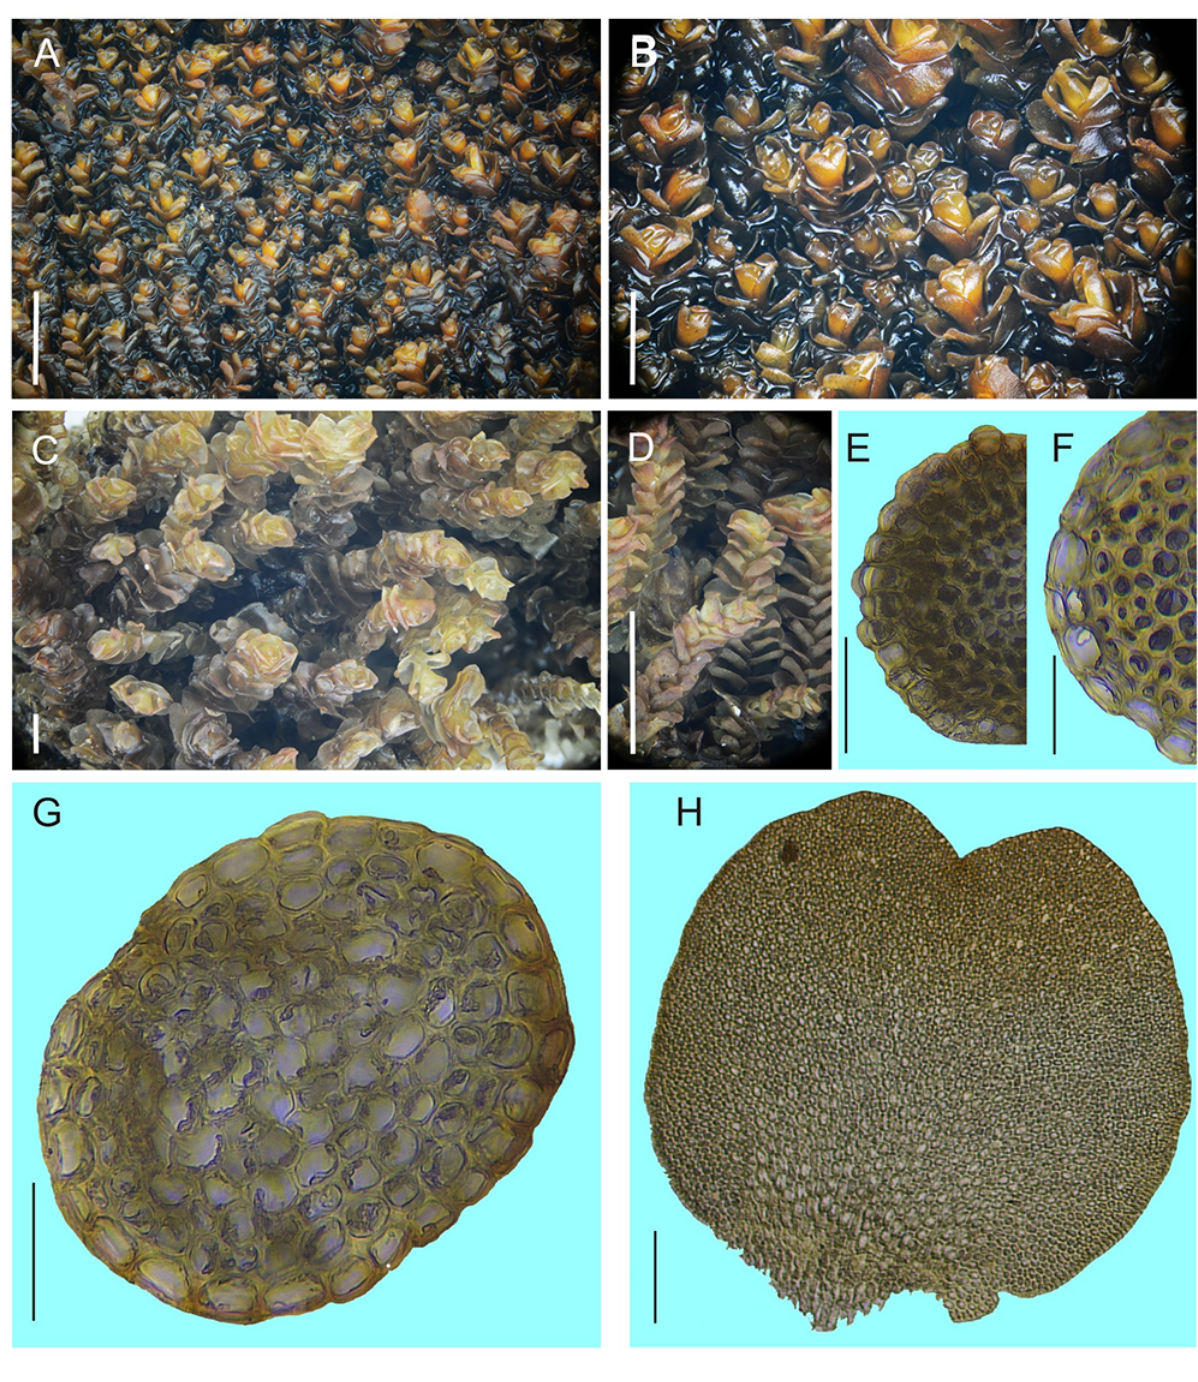
Figure 2 Marsupella subemarginata Bakalin & Fedosov from the Tatra Mountains. ( A–D ) Plant habit; ( E–G ) stem cross section; ( H ) leaf. ( A,B,G ) from POZNB 4037; ( C,D ) from POZNB 4036; ( E,H ) from POZNB 565; ( F ) from POZNB 4036. Scale bars: ( A ) 2 mm; ( B ) 1 mm; ( C ) 1 mm; ( D ) 3 mm; ( E ) 50 μm; ( F ) 50 μm; ( G ) 50 μm; ( H ) 200 μm. Photographs by R. Witkowski (A–D) and P. Górski (E–H)